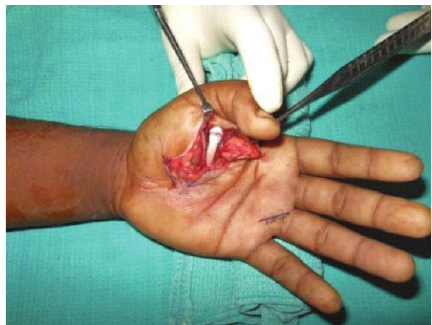
Figure 7: Follow-up, no extension lag.